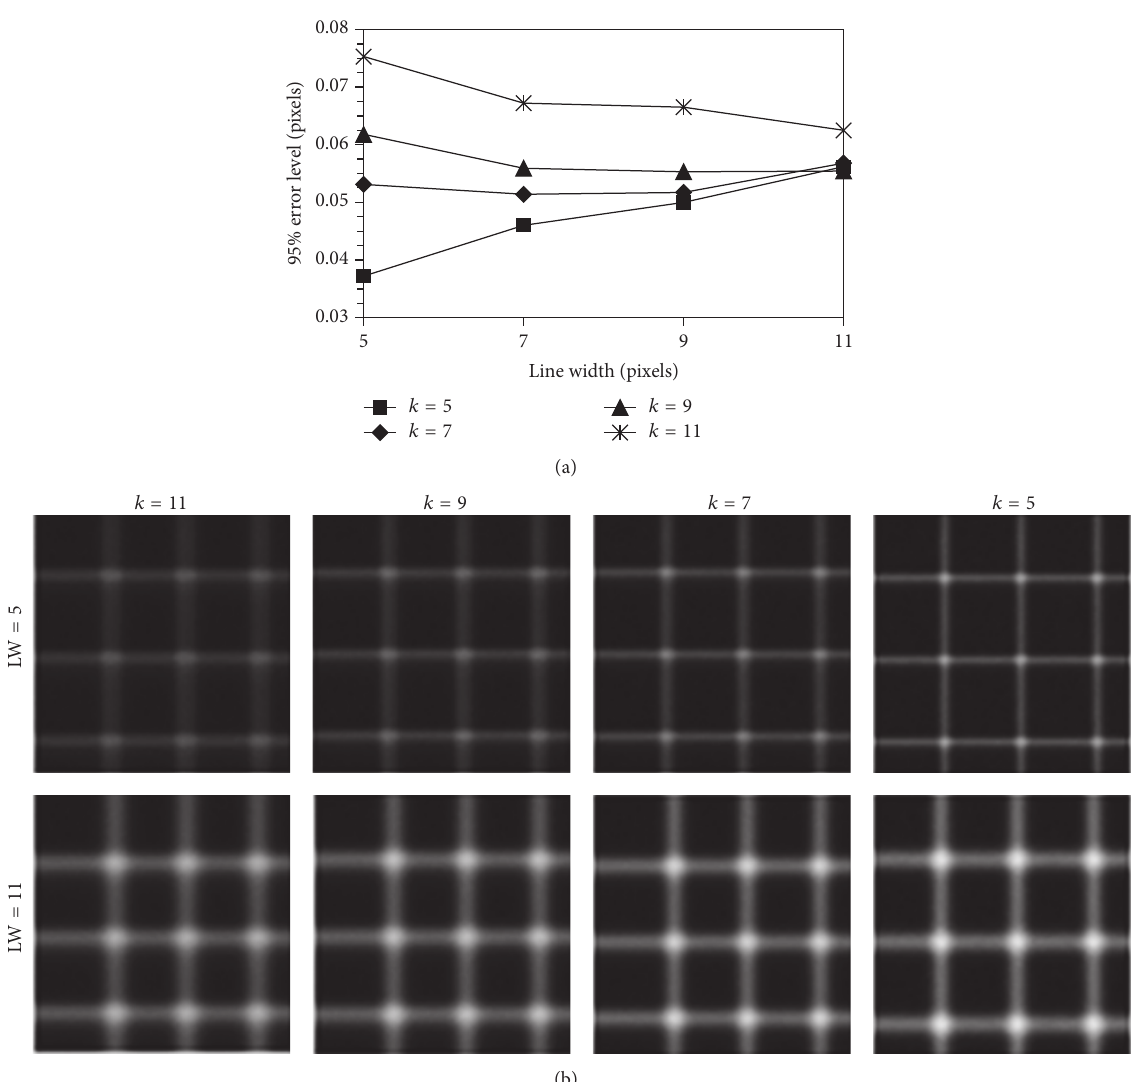
Figure 16: (a) RMS displacement error and (b) mean-filtered simulated images of different line widths and filter window sizes for less noisy image